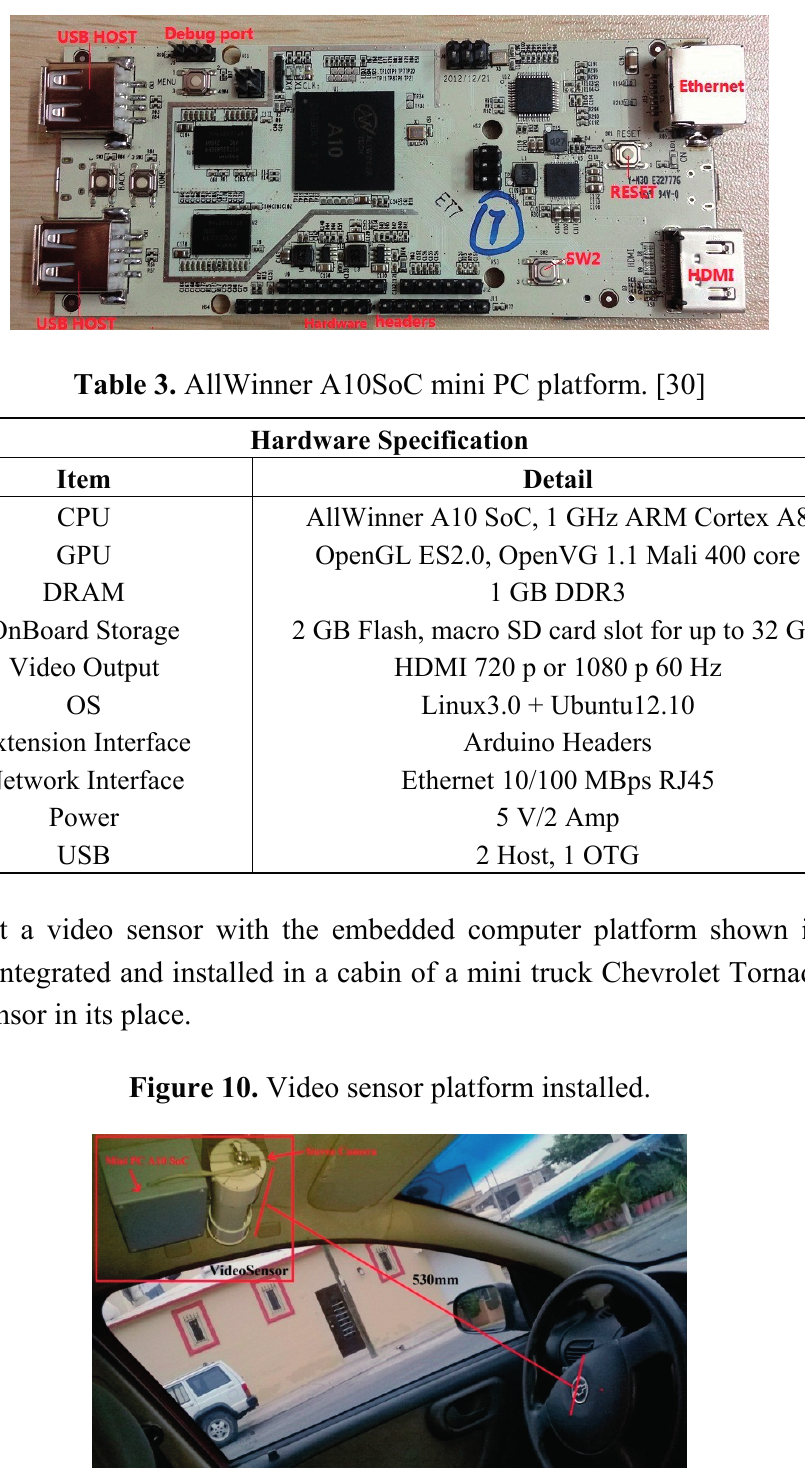
Figure 9. pcDuino mini PC platform.